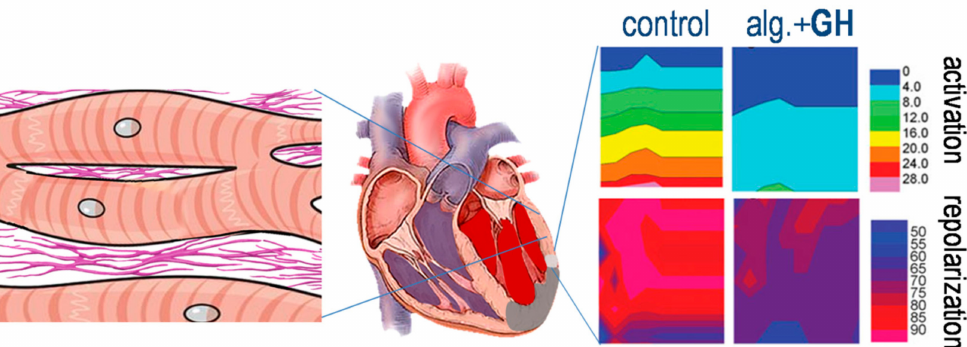
Figure 6. Electrophysiologic remodeling. Two proposed mechanisms of ameliorated electrophysiologic remodeling after treatment with growth hormone (GH), administered via an alginate (alg.) sca ff old: prevention of fibrosis in the non-infarcted myocardium ( left panel), and preservation of the peri-infarct area ( right panel), resulting in improved conduction and repolarization indices. Containing data from Kontonika et al., Growth Factors 35 (2017) 1–11 [43], with